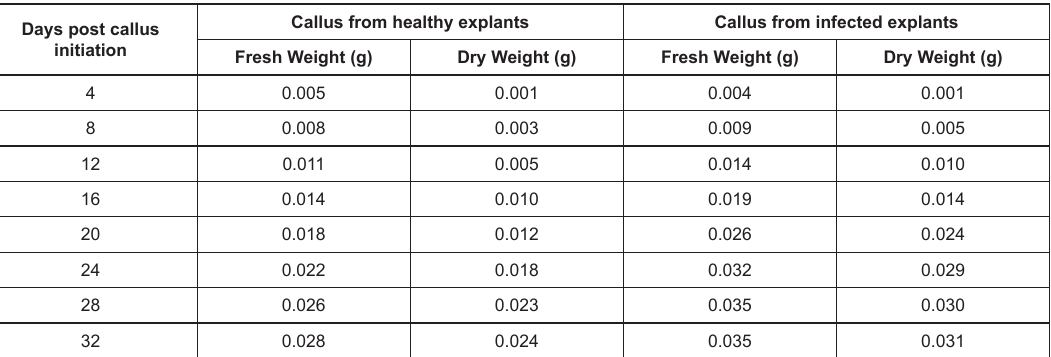
Table 1. Fresh weight and dry weight of the calli initiated from the healthy and infected explants. The calli from the infected explants grew faster but seized the growth after 32 nd day post callus initiation. The calli from the healthy tissues